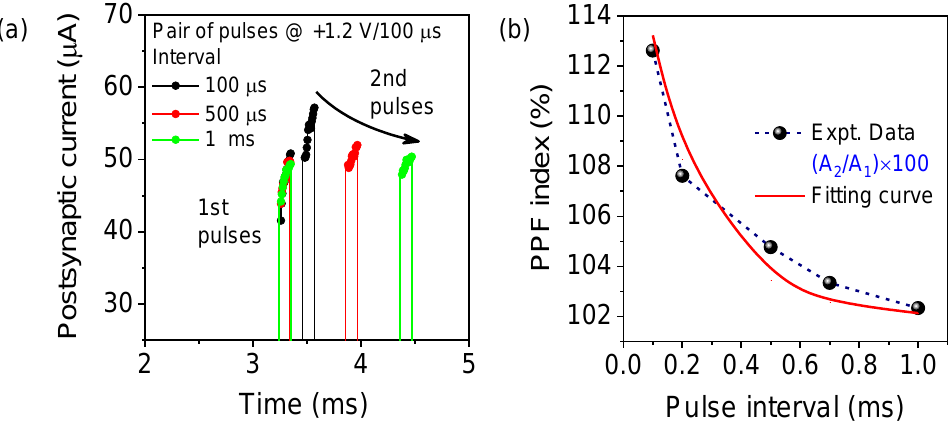
Figure 5. ( a ) Post-synaptic current response observed by applying a paired pulse with the different intervals of 0.1 ms to 1 ms on the ITO/WO x /TaO x /TiN memristor device. Pre-synaptic pulses were applied with an amplitude of +1.2 V/100 µs. ( b ) Experimental PPF ratios were calculated as a function of the pulse interval plotted as (A 2 /A 1 ) × 100% with a simulated curve using the model in Equation (1).